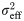
Network-generated oscillations.Oscillatory population spike rate and mean adaptation current of 50,000 excitatory coupled aEIF neurons and each of the derived models (for constant external input moments) generated by the interplay of recurrent excitation/adaptation current (A) and by delayed recurrent inhibition (B). In addition, the limit cycle of the LNexp model is shown in terms of the (quantity) steady-state spike rate r∞ as a function of effective input moments μeff, σeff2 (A, top) and for the spec2 model in dependence of the total input moments (μtot, σtot2 (A, bottom). The phase of the cycle is visualized by grayscale color code (increasing phase from black to white). The values for the input, adaptation and coupling parameters were μext = 1.5 mV/ms, σext=2mV/ms, a = 3 nS, b = 30 pA (A, top), μext = 1.275 mV/ms, σext=1.5mV/ms, a = 3 nS, b = 60 pA (A, bottom), K = 1000, J = 0.03 mV, τd = 3 ms (A, both). In B adaptation was removed (a = b = 0) and delays were identical dij = d; input and coupling parameter values were μext = 1.5 mV/ms, σext=1.5mV/ms, K = 1000, J = −0.0357 mV, d = 10 ms (top) and μext = 3 mV/ms, σext=2mV/ms, K = 1000, J = −0.087 mV, d = 5 ms (bottom).